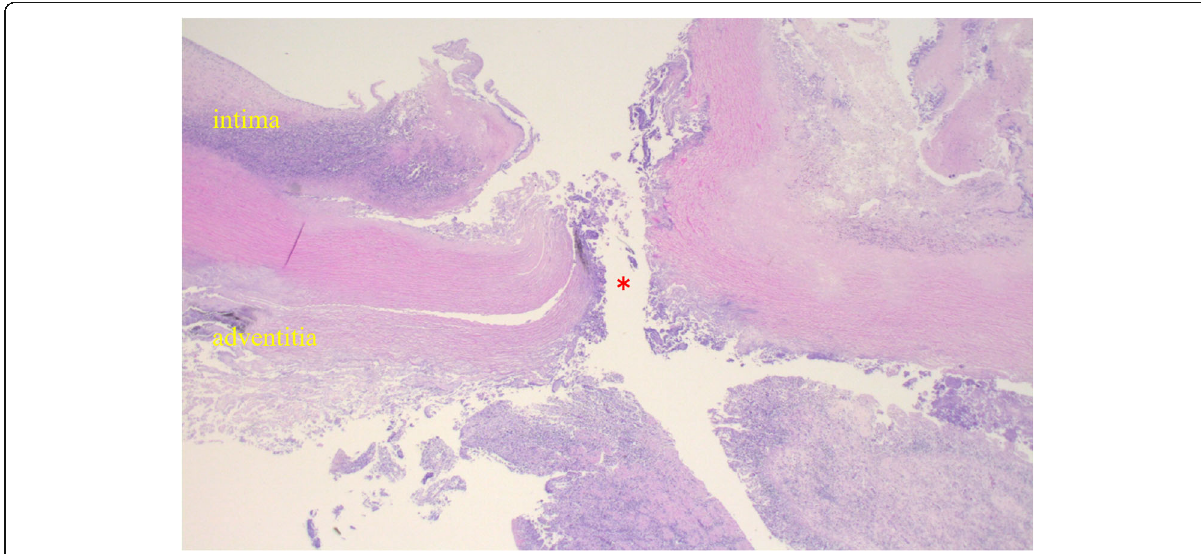
Fig. 5 Microscopic findings showing a fistula between the aortic wall and the overlap esophagojejunostomy site. The fistula appears as a tract from the adventitia to the intima of the aorta (asterisk). There is no thermal denaturation of the adventitia of the aortic wall, and only a small amount of neutrophils are present in the